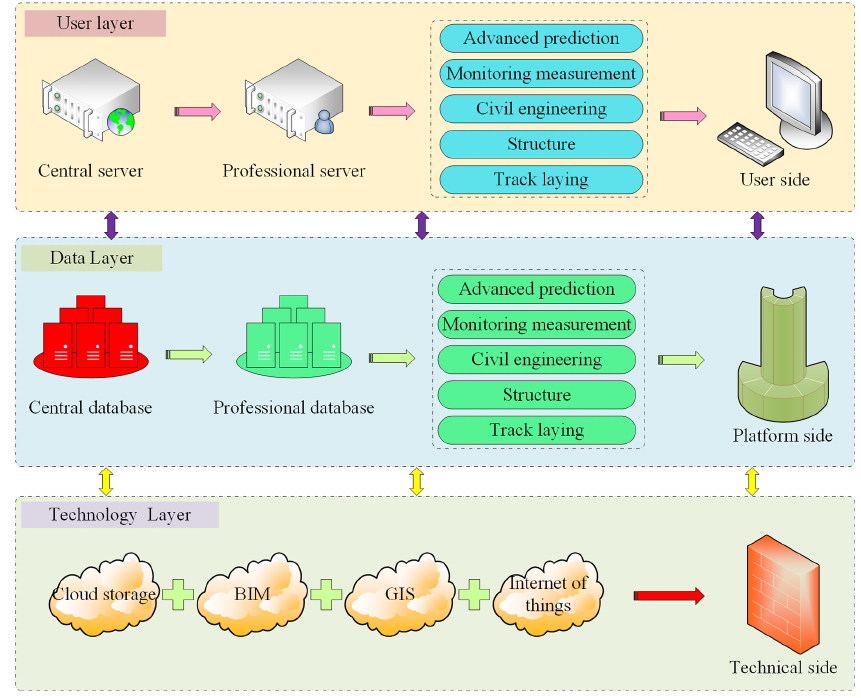
Figure 3. Core technology diagram of tunnel engineering collaborative management